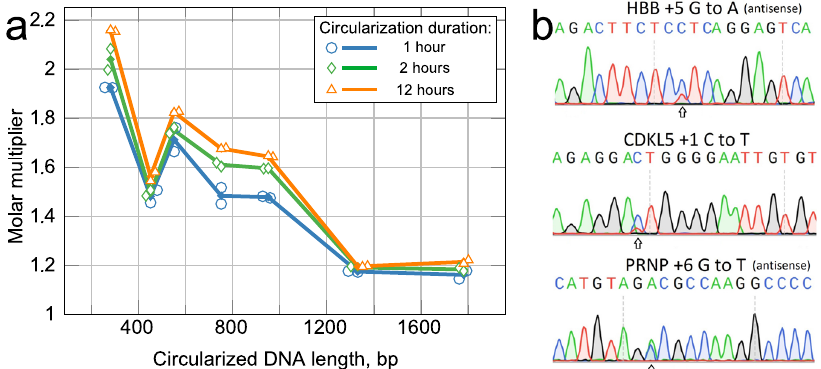
Fig. 4 Effects of ligation duration and Circular Vector length on molar multiplier and Sanger sequencing validation of editing ef fi ciency. a Molar multiplier by length and circularization duration. Between 452 bp and 952 bp, a simple rule of thumb based on the distribution is a 1.5× multiplier after 1 h of circularization, and 1.7× for 2 h of circularization or longer. For example, if the Cas9 plasmid is 13,000 bp long and single circular vector is 452 bp long, then 1.0 μ g of the main plasmid at molar ratio 1:1 will require 1.0 × 452/13,000 = 0.035 μ g = 35 ng. Multiplying by 1.5 will result in 52 ng of a vector rather than 35 ng for a 1:1 molar ratio based on a 1 h circularization reaction. The line nodes represent the averages of n = 2 independent reaction samples calculated from the gel electrophoresis band brightness; the dots show individual data samples for the nodes, horizontally offset for visibility. b Validation of the Circular Vector by prime editing HBB, CDKL5, and PRPN. Table 1 Comparison of prime editing ef fi ciency with that of Chen et al. 15 for matching HBB, CDKL5, and PRPN locations. Reference Chen et al. a (%) This research (%)